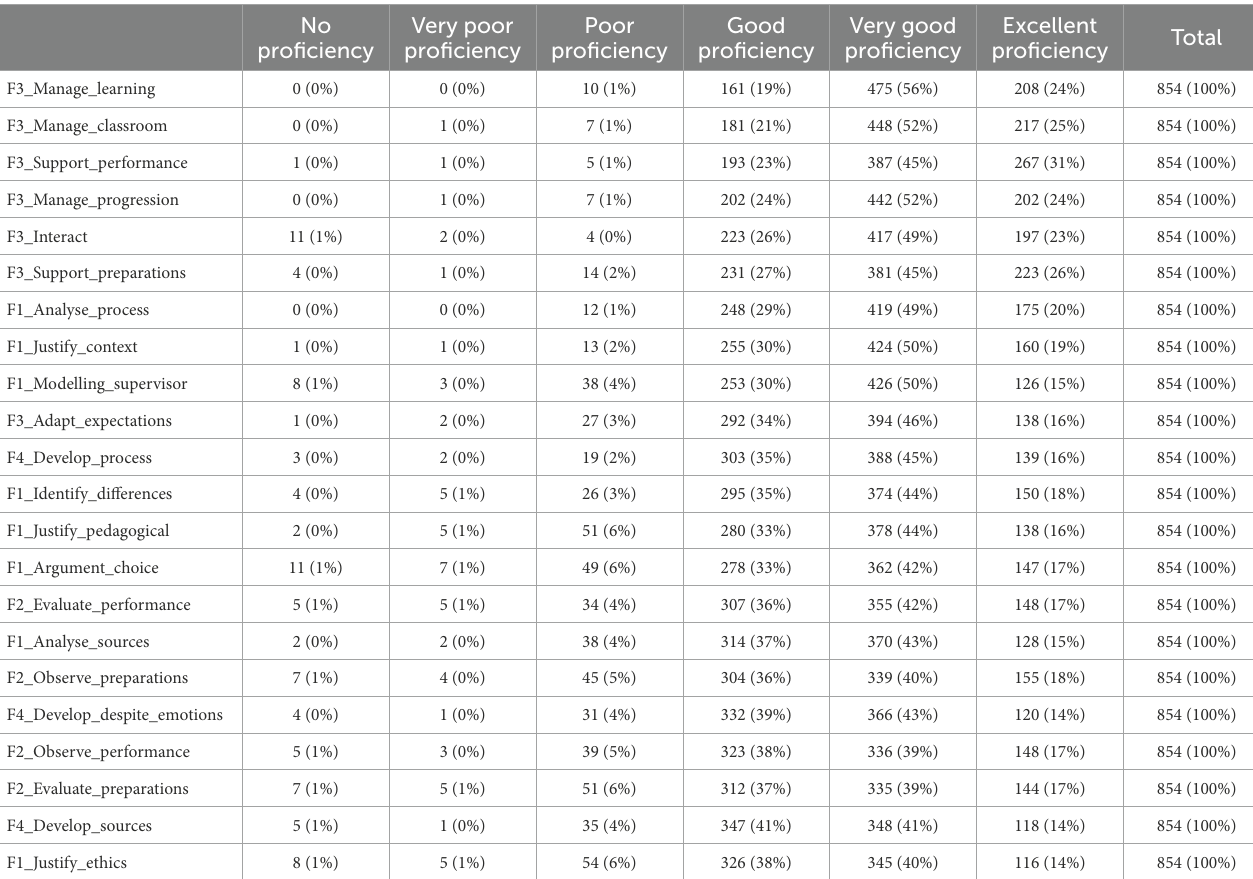
TABLE 5 Distribution of responses (N = 854) across the levels of the Likert scale. (In this table, the items are ranked from the item with the most “very good or excellent proficiency” responses to the one with the least). No Very poor proficiency proficiency